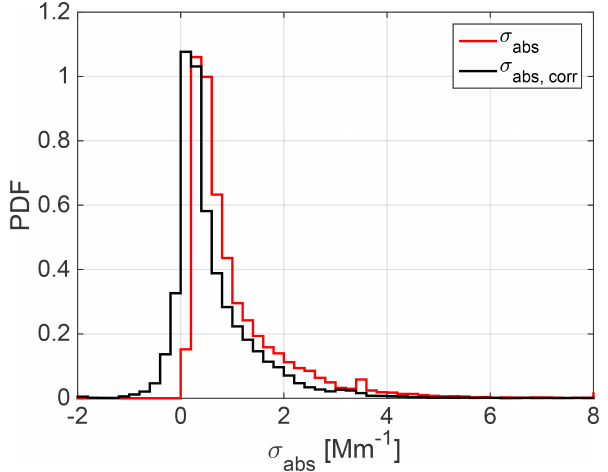
Figure B1. Probability density functions (PDFs) of σ abs as red line and σ abs , corr as black line.